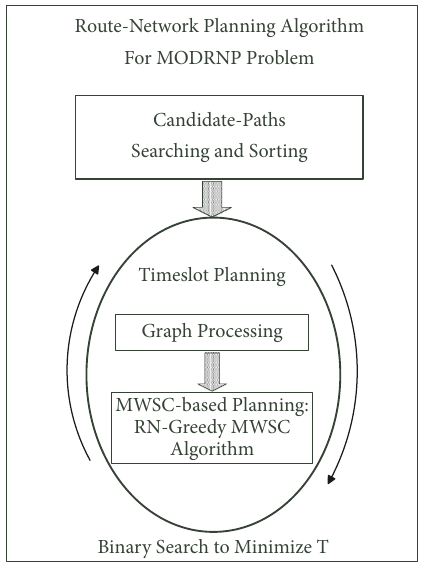
Figure 2: The framework of Route Network Planning